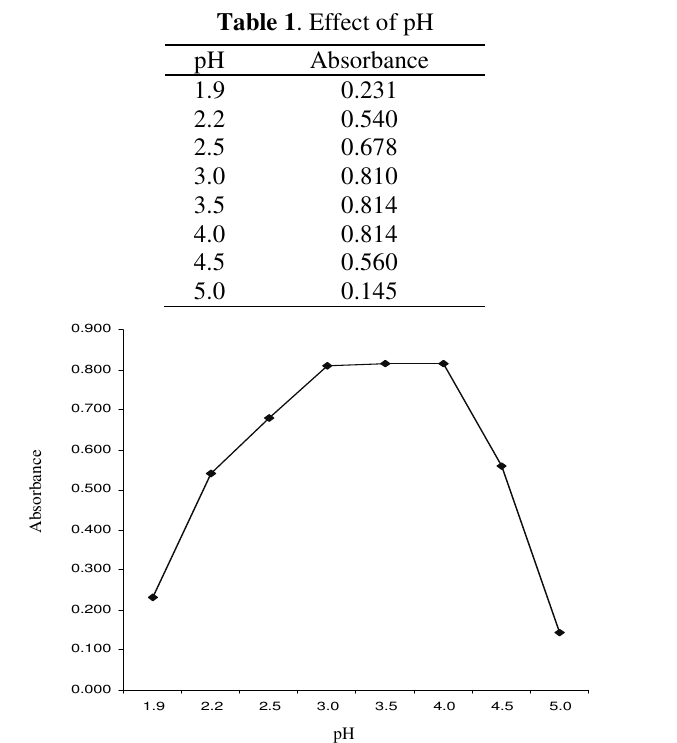
Figure 2. Effect of pH on absorbance of Mo(VI)-GPPH